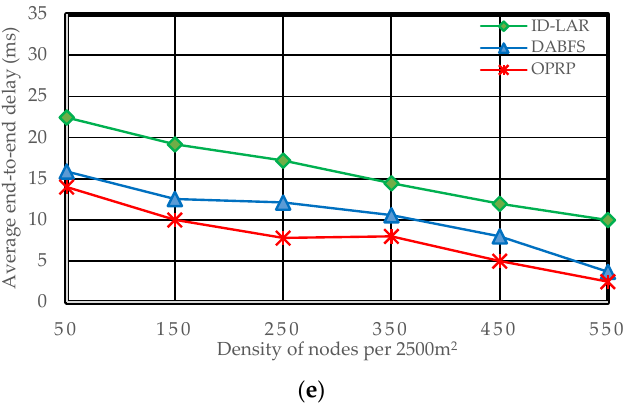
Figure 6. End-to-end delay during the dissemination of WM. ( a ) Scenario 1: H (S, D) = 1, S is rear and D front node. ( b ) Scenario 2: H (S, D) = 1, S is font and D is rear node. ( c ) Scenario 3: H (S, D) = 0, S and D are moving toward each other. ( d ) Scenario 4: H (S, D) = 0, S and D are moving away from each other. ( e ) Scenario 5: H (S, D) = 0, S and D are moving toward each other in opposite directions.